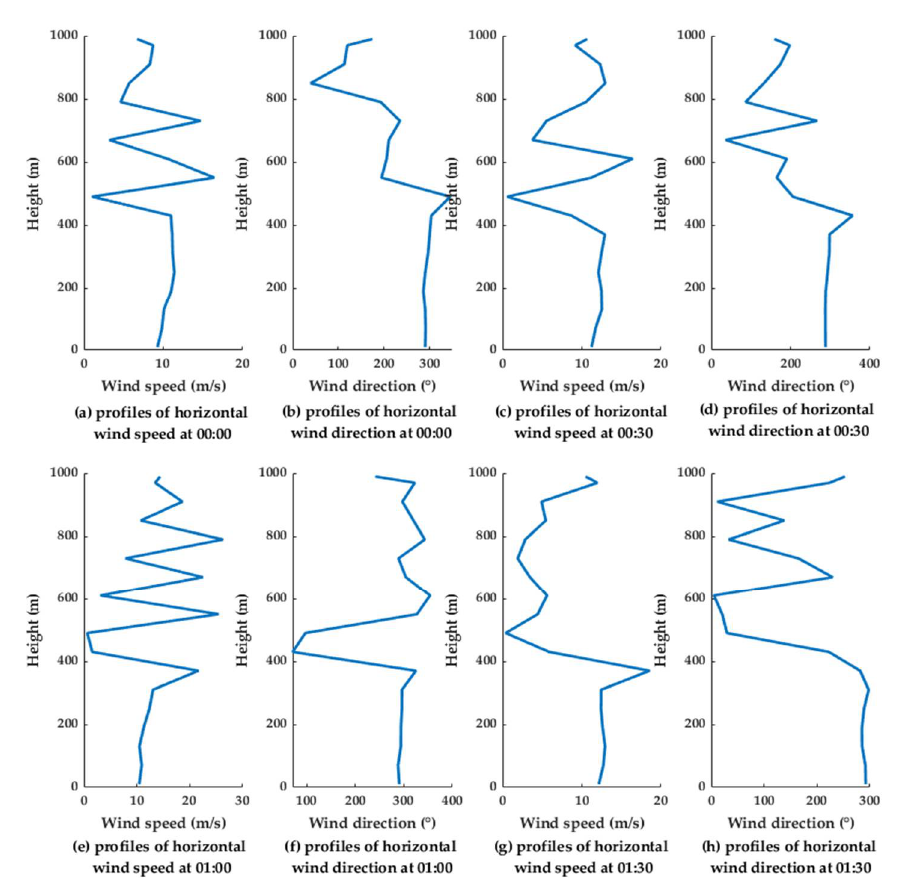
Figure 8. Profiles of the horizontal wind speed and direction from 00:00 to 01:30 on 6 March 2021.